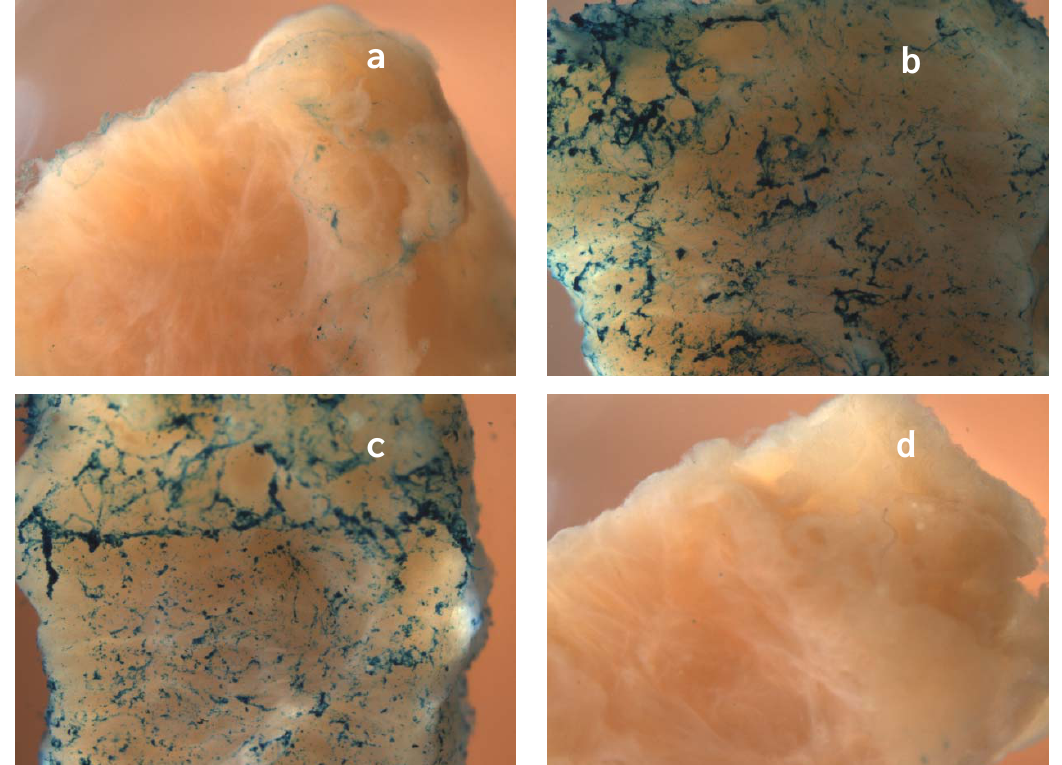
Figure 4. Macrophotographs (at 10x magnification) of tissue samples exposed to uncomplexed ABG (a), {bTAT+ABG} (b) and {bTP+ABG} (c) in the experiment abbreviated as “hyperplasia” (see Table 1 for the details). The tissue samples were from the specimen diagnosed with hyperplasia of the endometrium without atypia. The image of the negative control (“no drug”) is in panel